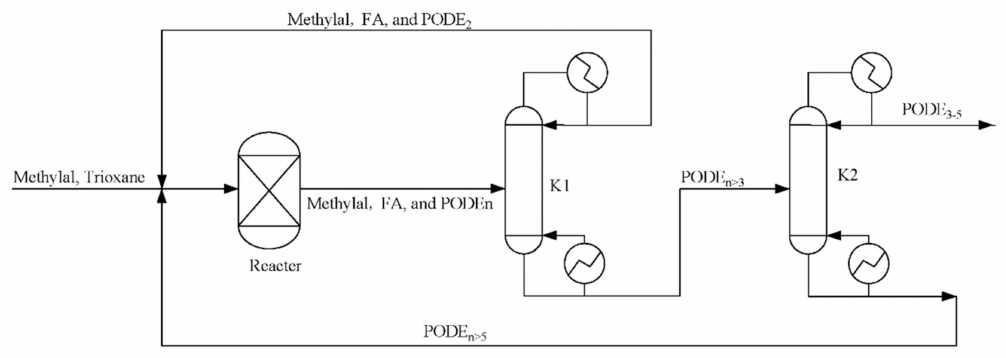
Figure 9. The reboiler duty of each equipment in the process of formaldehyde et al. (Methylal / CH 2 O mass ratio 2:1).